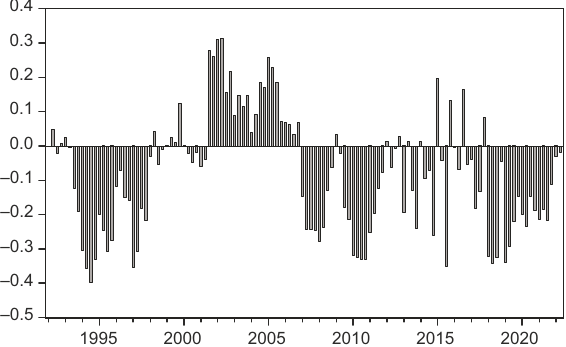
Figure 5. Amplitude of fluctuations in the long-run potential growth rate between two adjacent